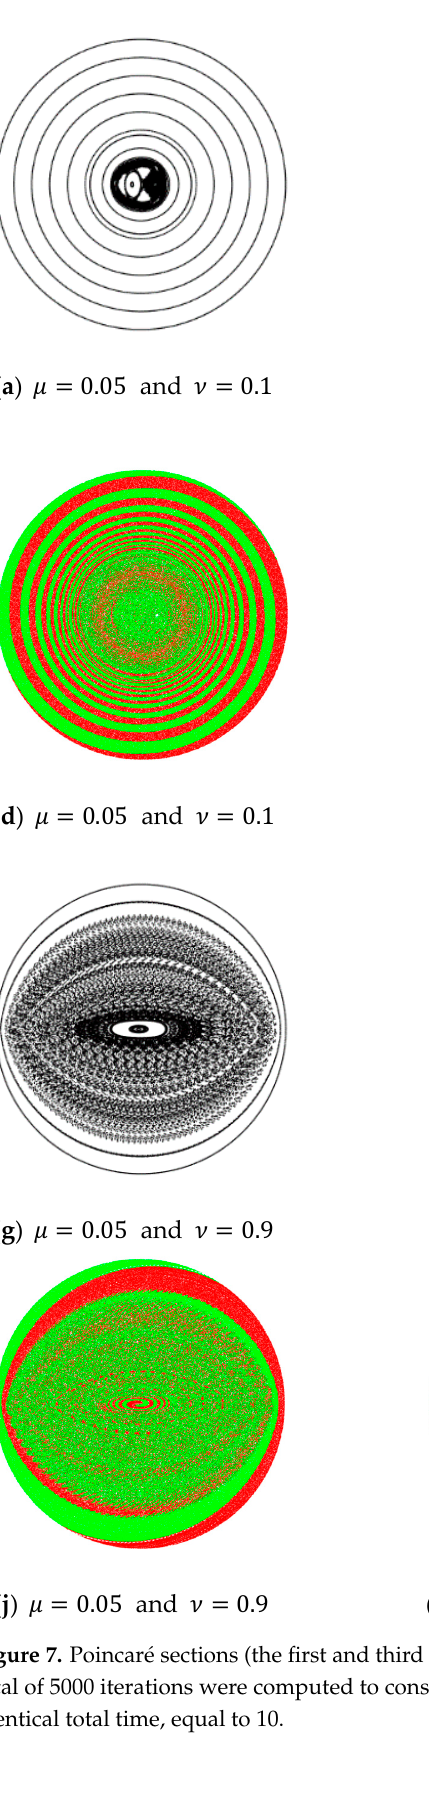
Figure 6. The effect of the transition time ( 𝑟 (cid:3047)(cid:3045)(cid:3028)(cid:3041)(cid:3046) ) and fixed vortex centre ( 𝜈 ) on mixing performance ( 𝐼 ) with fixed total time of 10, which indicates that ( a ) iterations are 200; ( b ) 80; ( c ) 40; ( d ) 20; and ( e ) 10 with different periods ( 𝜇 ). Note that Figure 6e is identical to Figure 5e.